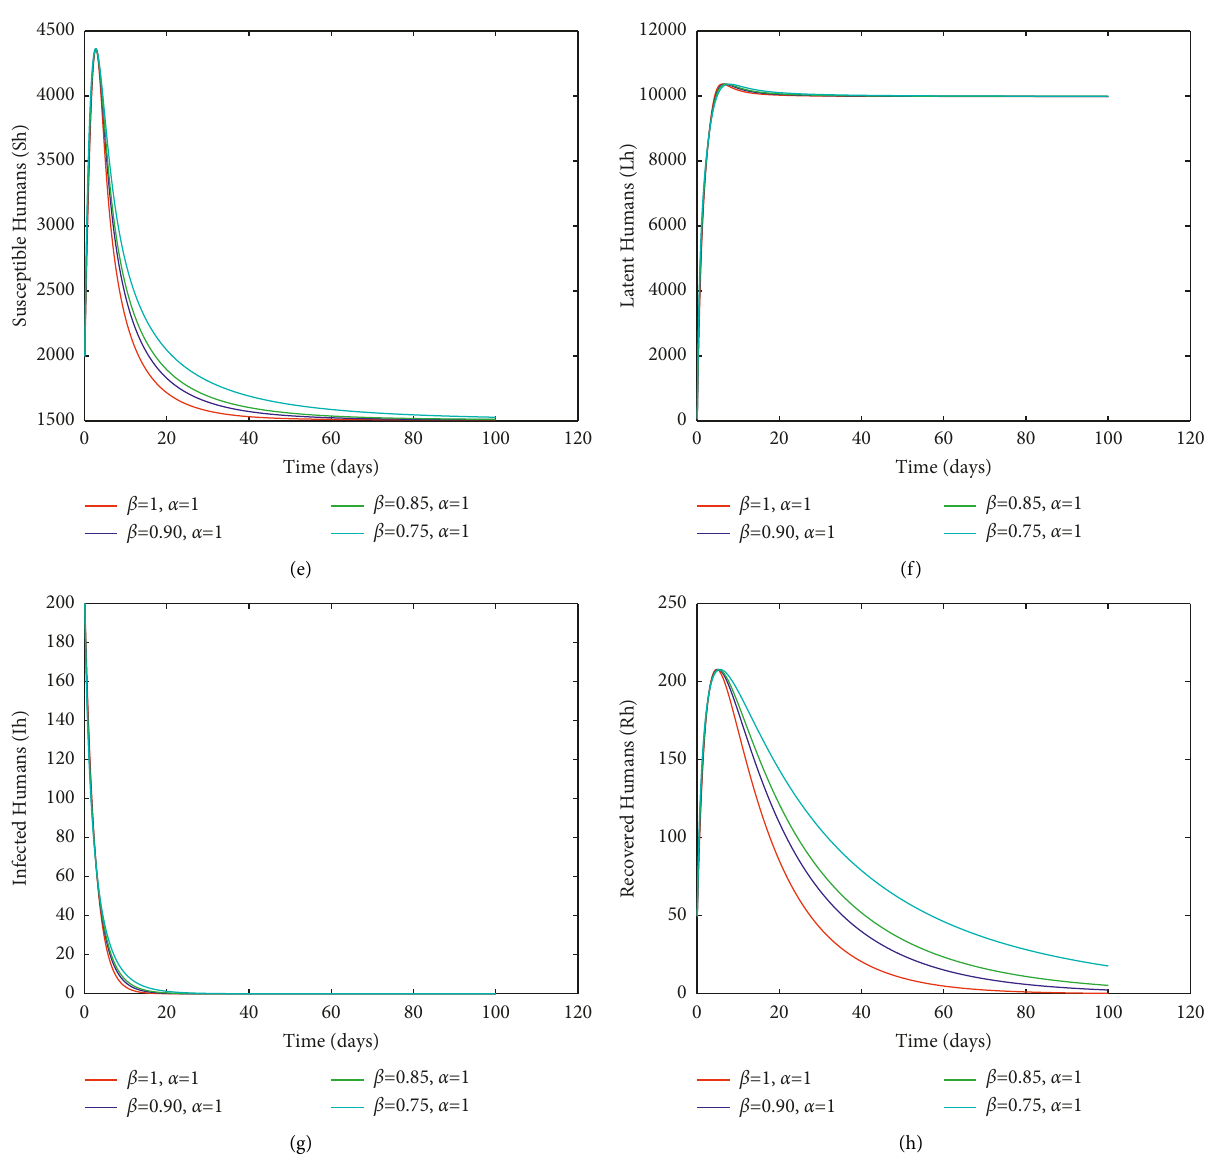
Figure 1: Simulation of fractional conformable model (7), when β � 1 , β � 0 . 90 , β � 0 . 85 , β � 0 . 75, and α �